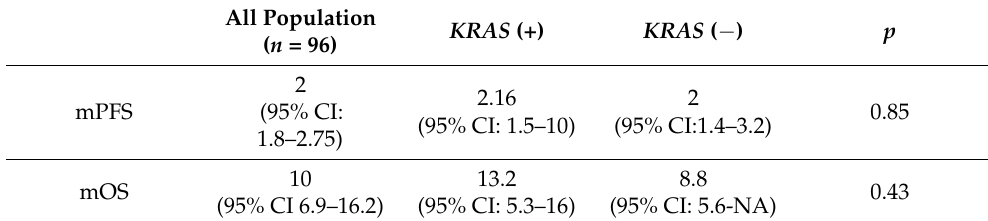
Table 3. Survival parameters in the entire analyzed population.